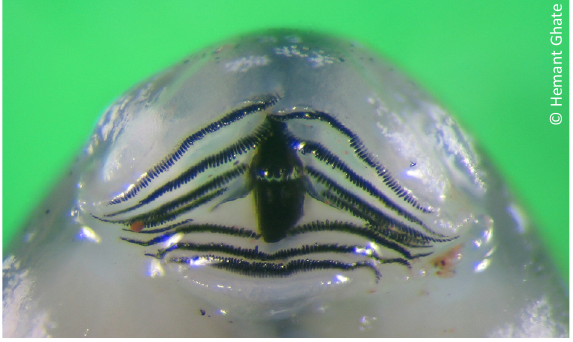
and I. phrynoderma (Fig. 2a). Indirana chiravasi sp. nov. was separated from I. brachytarsus , I. gundia and